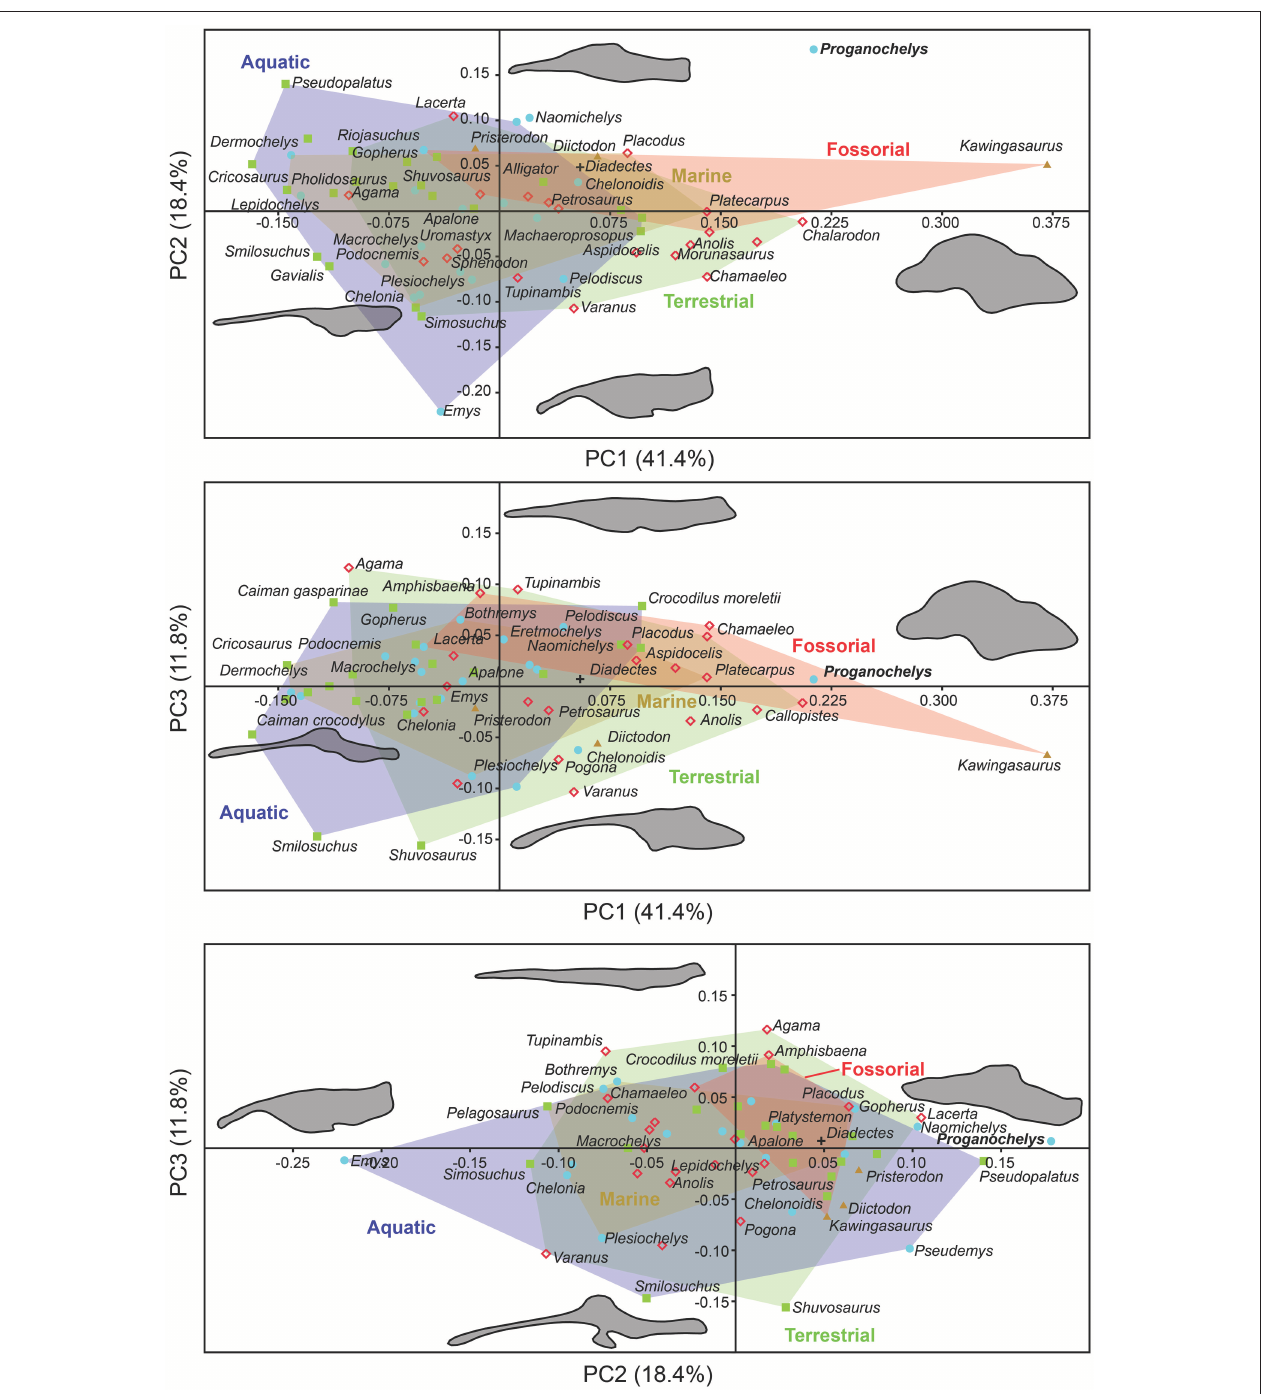
FIGURE 6 | Two dimensional morphospace plots of brain endocast outlines based on the first three PC axes using a priori defined ecological groups. Diadectes is shown as a black cross, Proganochelys quenstedti (SMNS 16980) in bold. The symbols are used to identify the clade to which a point was assigned. Different ecological groups are indicated by convex